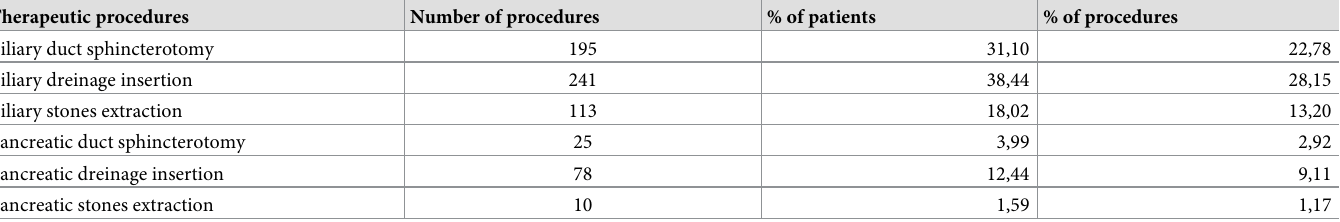
Table 3. Therapeutic procedures.